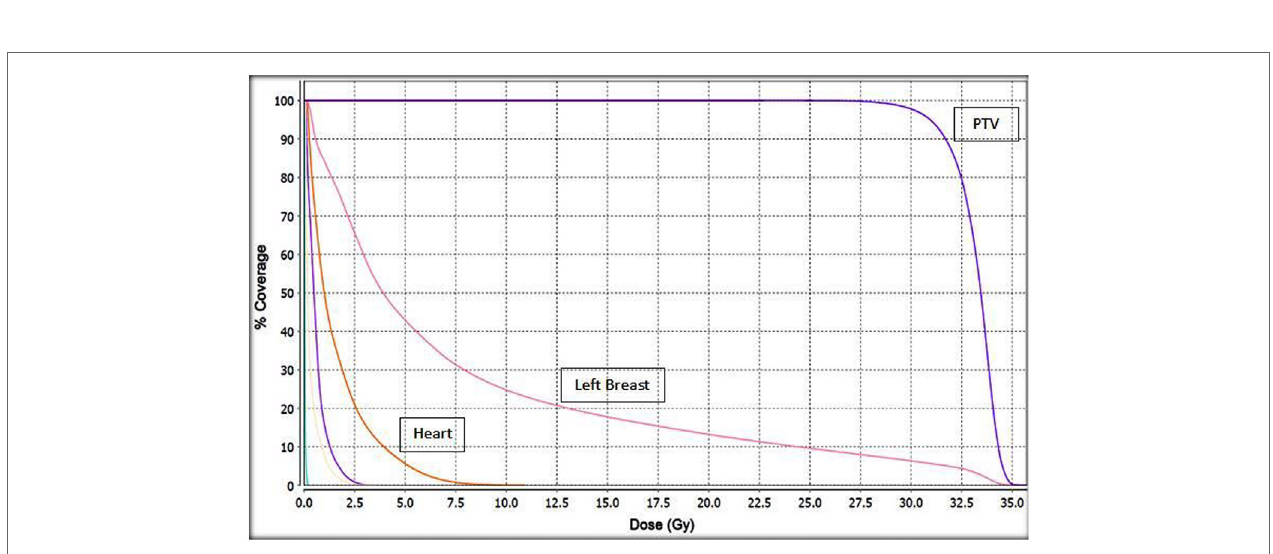
FigUre 1 | axial, sagittal, and coronal views of the treatment planning cT scan demonstrating the PTV (purple) and normal breast (pink), isodose lines shown as follows: 100% of the prescription dose, red line; 50% of the prescription dose, green line; arrow points to gold fiducial marker